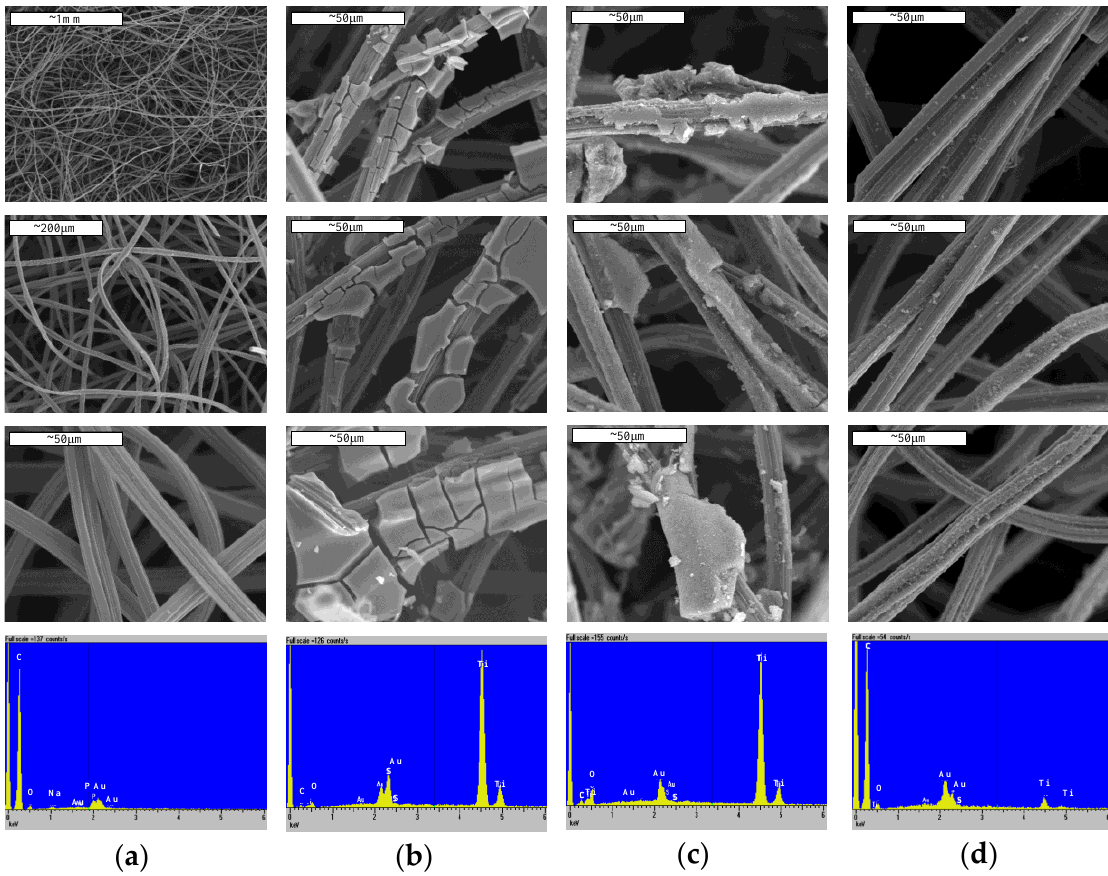
Figure 1. SEM photomicrographs and EDS analysis results of ( a ) the original ACF at di ff erent resolution values, ( b ) ACF / TiO 2 photocatalytic adsorbents prepared by the dip-coating method in TTIP sol at 10,